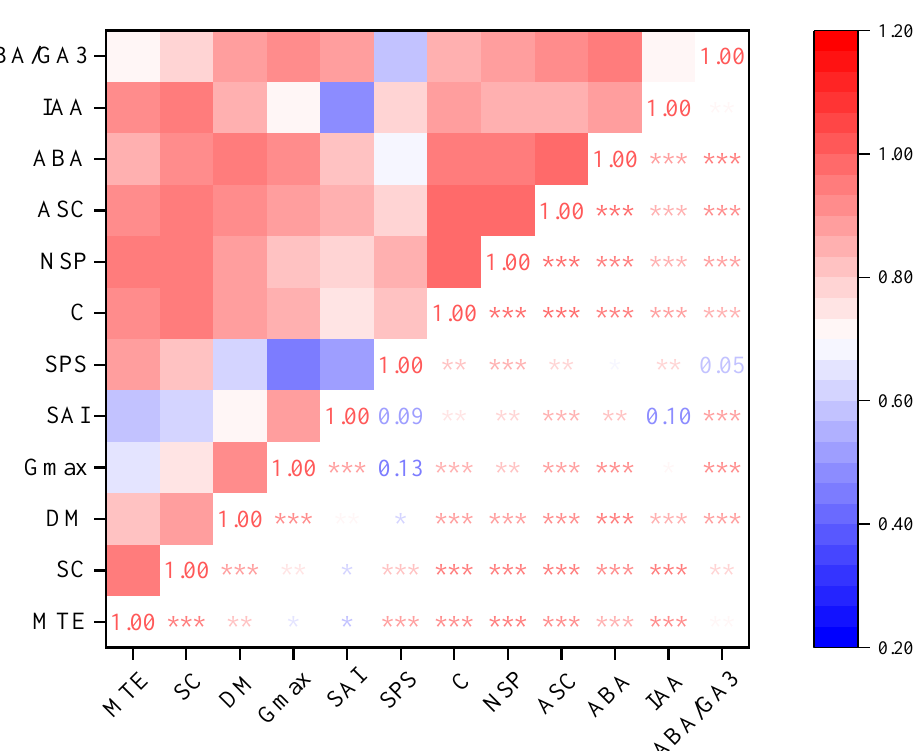
Figure 7. Correlation analysis among MTE, C content in grain, DM, sink capacity, Gmax, enzymes activity, small vascular bundle structure, and hormones content throughout all treatments of this study in 2018. MTE, Matter transport efficiency of peduncle; SC, sink capacity; DM, Accumulation of total dry matter; Gmax, Maximum grain-filling rate; SAI, Soluble acid invertase; SPS, Sucrose-phosphorus synthase; C, grain carbon contents; NSP, Number of small vascular bundle in peduncle; ASC, Phloem area of small vascular bundle in cob; IAA, indoleacetic acid; ABA, abscisic acid; ABA/GA3, The ratio of abscisic acid to gibberellic acid. *, ** and *** indicate significant difference at p < 0.05, p < 0.01 and p < 0.001, respectively.